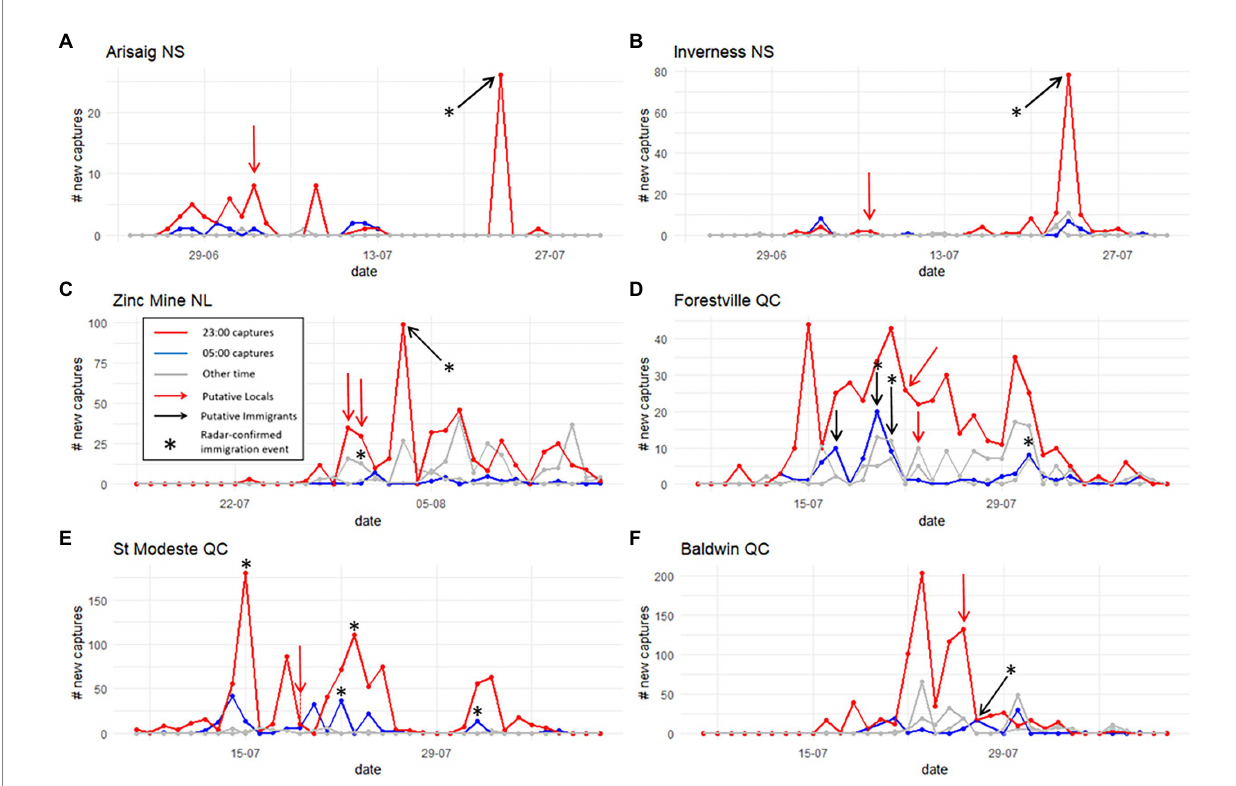
FIGURE 2 Number of eastern spruce budworm moths caught at each site on a given date and time. Each panel represents the flight season (June to August) captures of a given trap (A–F) . Moths collected between 17:00 and 23:00 (red line) are often assumed to be putative locals, whereas moths captured between 23:00 and 05:00 (blue line) are generally interpreted as putative immigrants. Captures between 5:00 and 17:00 (gray lines) are more difficult to interpret and could be composed of late-arriving immigrants or early-flying locals. Arrows indicate time of sampling of local individuals (red arrows) and immigrant individuals (black arrows) for isotope